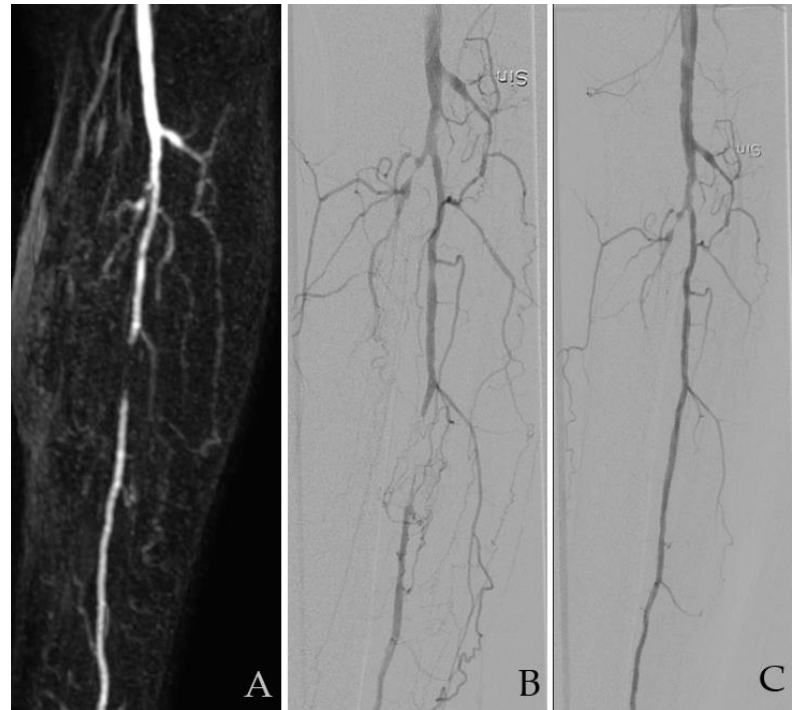
Figure 1. A 68-year smoking patient with type-2 diabetes. He presented with ischemic wounds and gangrene dig 1. Images showing an occlusion in the anterior and posterior tibial artery and a short proximal occlusion in the fibular artery (FA). ( A ) Magnetic resonance angiography (MRA) and ( B ) digital subtraction angiography (DSA) before and ( C ) after revascularization. All four observers graded this as TASC B with FA as a target vessel. Sin: Sinister/left. TASC = TransAtlantic Inter-Society Consensus for the Management of Peripheral Arterial Disease.